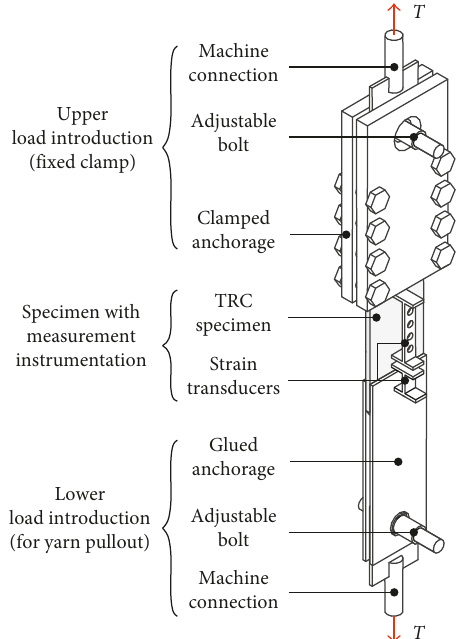
Figure 3: Test setup for the development length of the textile (textile pullout test).